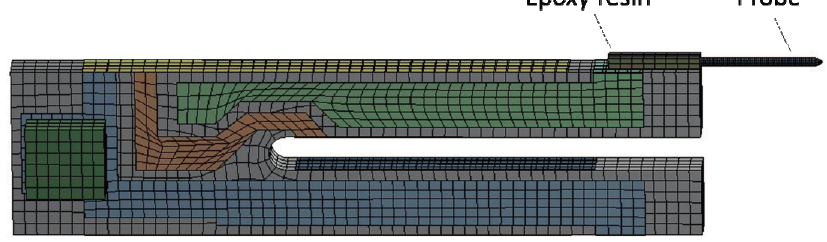
Figure 13. Geometry and meshing of the TF-probe with FEM analysis.